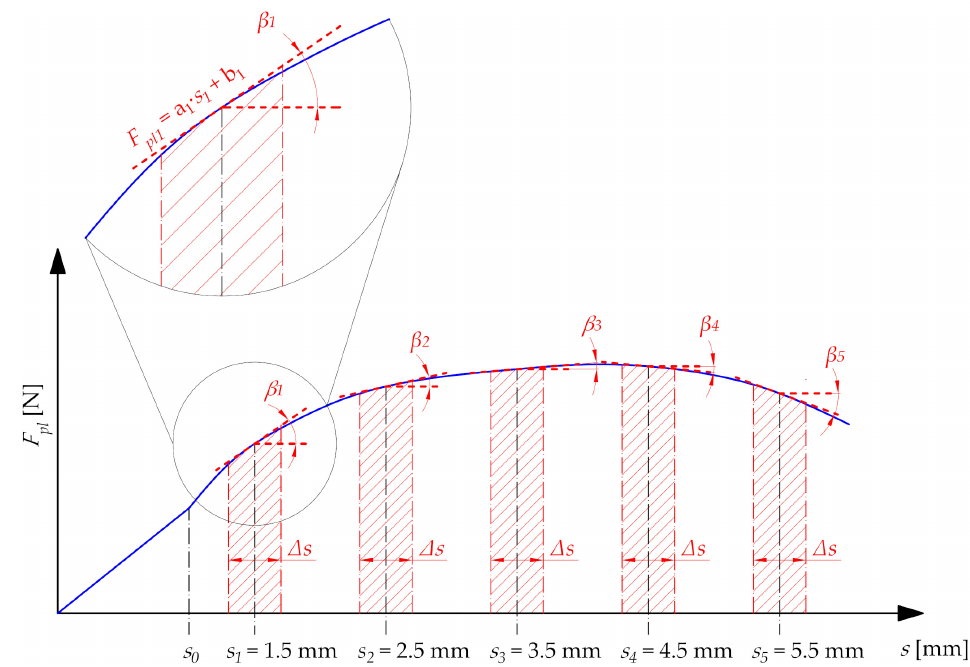
Figure 16. Exemplary real plasticization characteristic F pl ( s ) with the method of examination of non-steady plasticization function: F pl 1 … F pl 5 —value of the plasticization force, s 0 —initial displacement (the border of the non-steady state), s 1 … s 5 —analysed control points, Δ s —considered range of displacement, a 1 … a 5 —directional coefficients of the approximation function, b 1 … b 5 —constants of the approximation functions, β 1 … β 5 —angle of inclination between the approximation function and plasticization characteristics, tangent at points s 1 … s 5 .